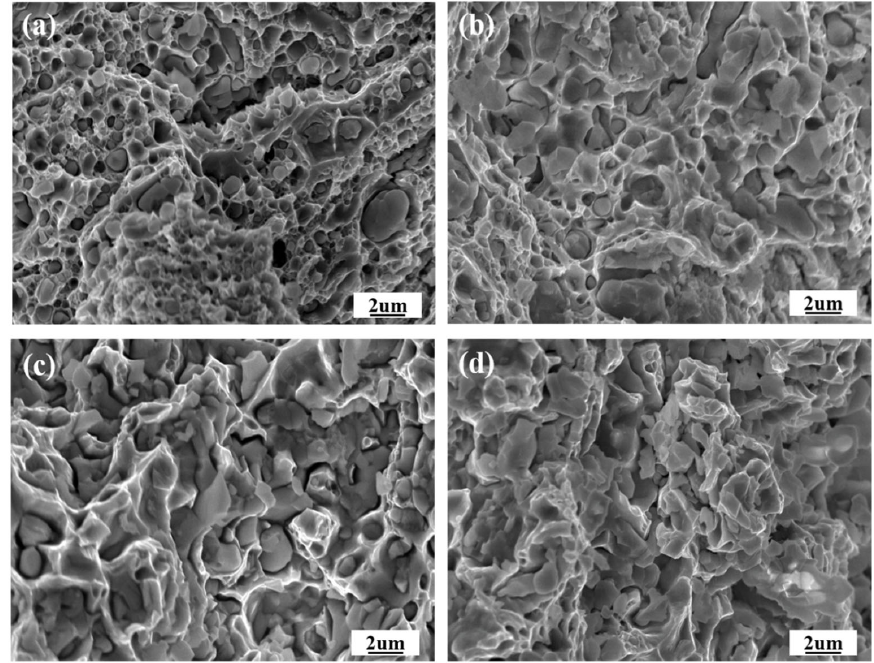
Figure 12. FESEM images of the fracture morphology after tensile tests: ( a ) HP5; ( b ) HP10; ( c ) HP15; ( d ) HP20. ( d )